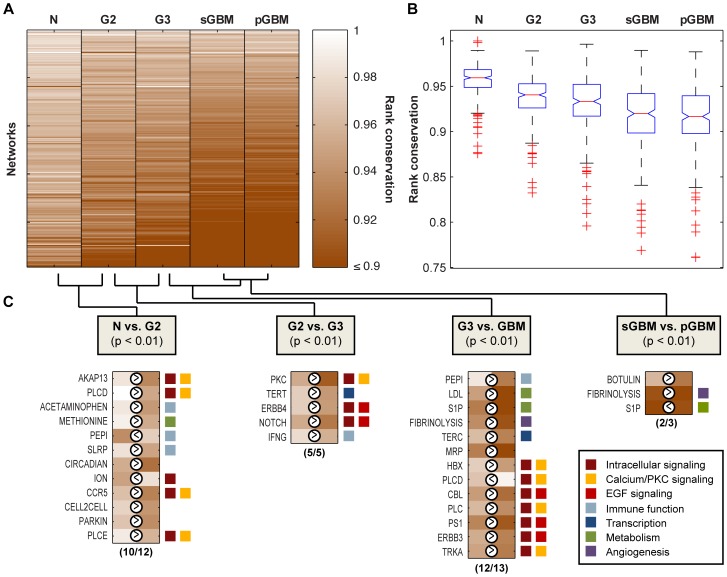
Network-level expression heterogeneity across tumor grades.
A) Global trend of network regulation level decreases with increeasing grade. The vertical axis represents examined networks, while the horizontal axis represents five phenotypes. Colors represent rank conservation indices for each network. Light colors indicate high consistency of network ranking in a phenotype and the dark colors indicate large heterogeneity of networks. Networks in sGBM and pGBM tumors become much more heterogeneous compared to the normal cases. B) One-way ANOVA comparing the mean rank conservation values of different phenotypes. C) A list of most deregulated networks between adjacent tumor grades and their major biological functions. The “>” and “<” indicate the magnitude of network regulation. For instance, AKAP13 has a larger rank conservation index in normal samples and thus is more regulated in normal compared to G2 patients.